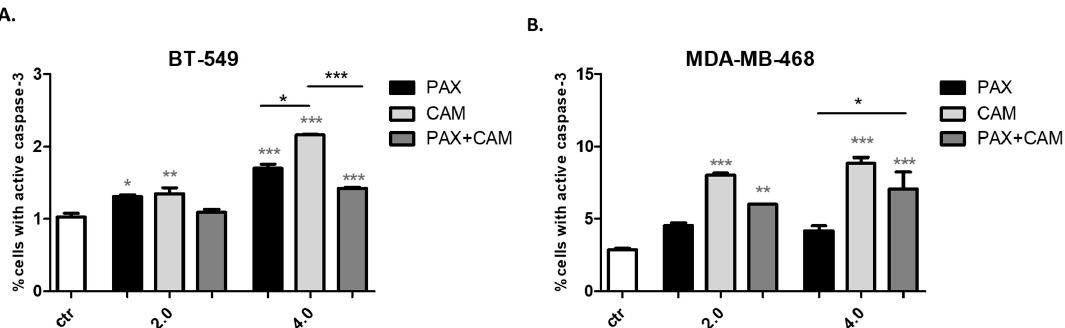
Figure 7. Effect of CAM and PAX alone or in combination on caspase ‐ 3 activation in ( A ) BT ‐ 549 and ( B ) MDA ‐ MB ‐ 468 TNBC cells. BC cells were exposed to drugs treatment for 48h using selected ratios of the IC 50 determined in the MTT assay (2.0 = IC 50 , 4.0 = 2IC 50 ) and analyzed by FACS. Data are presented as mean ± standard deviation (±SD); one ‐ way ANOVA, Tukey’s post ‐ hoc testing; * p < 0.05, ** p < 0.01, *** p < 0.001. Grey * ‐ data vs. ctr; black * ‐ single treatment vs. combined treatment.